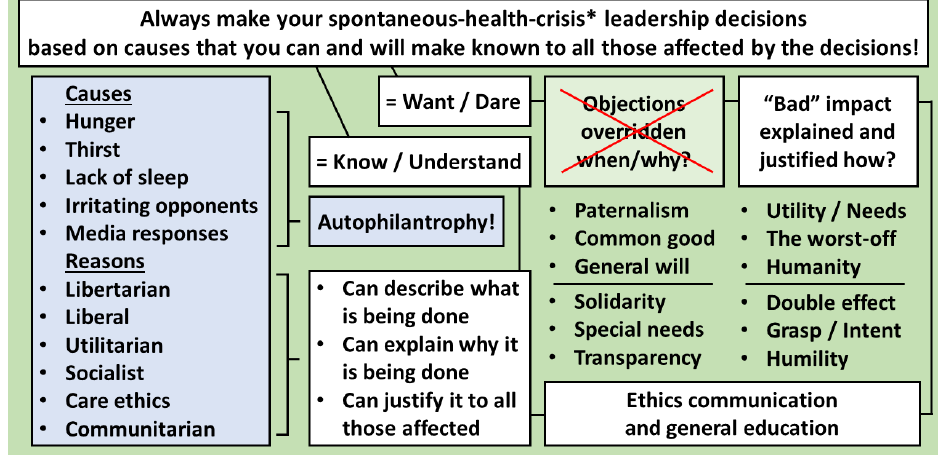
Figure 2. The imperative of openness, its elements, and its implications.